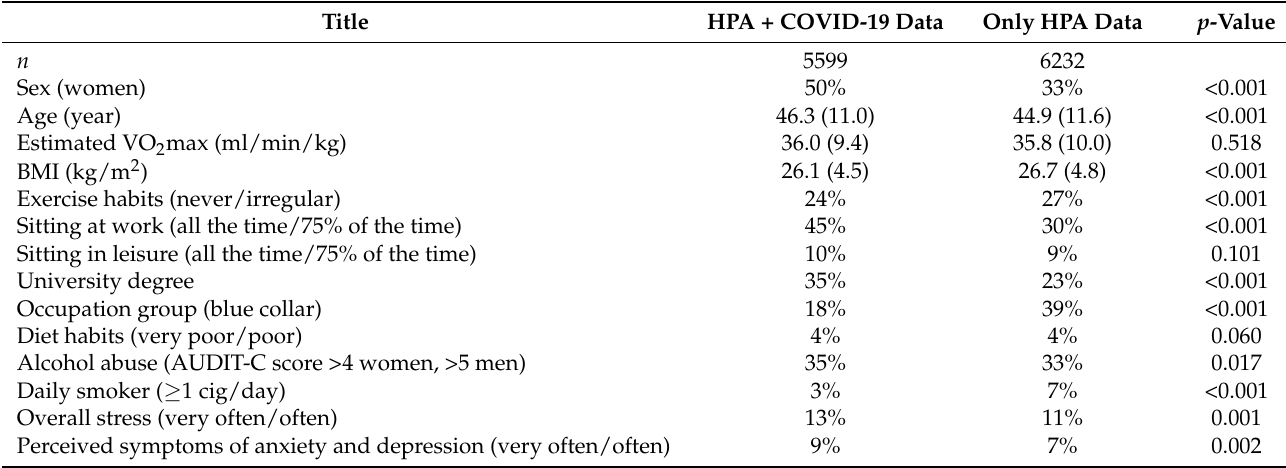
Table 1. Participants with data from the health profile assessment (HPA) and the additional COVID-19 questions ( n = 5599), and participants with only HPA data ( n = 6232) between 21 April 2020 and 2 December